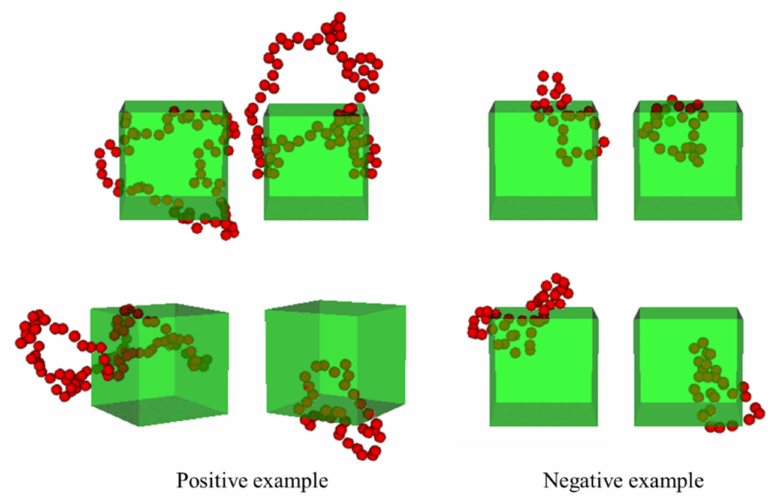
Figure 9. Examples of the loops composed of filler particles, which were extracted by the PH. The green box denotes the modeled space, and the red dots represent the filler